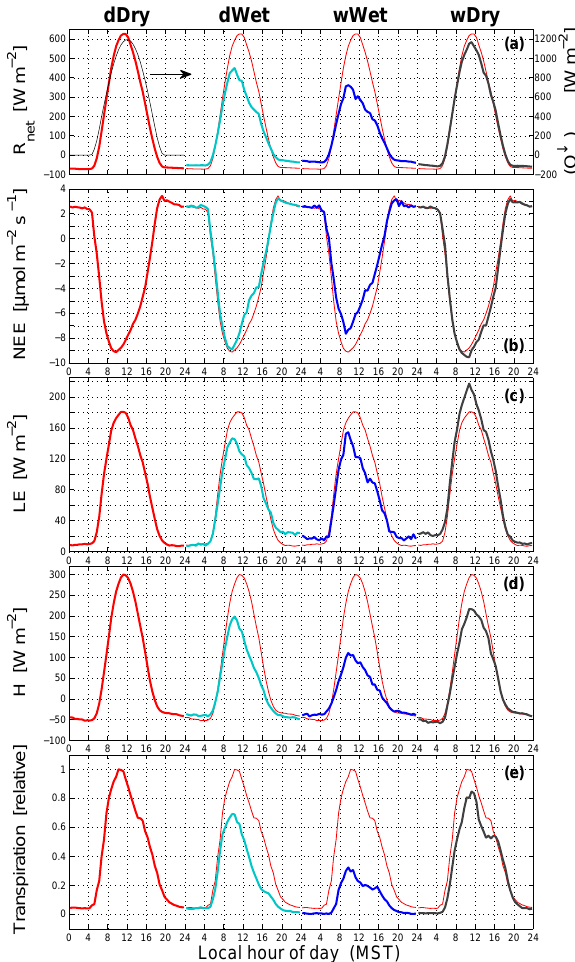
Figure 9. The mean warm-season diel cycle of (a) net radiation R net , (b) net ecosystem exchange of CO 2 NEE, (c) latent heat flux LE, (d) sensible heat flux H , and (e) transpiration (in relative units). The diel cycle for each precipitation states are shifted to the right following the description above panel (a) . For reference, the dDry diel cycle is repeated in all columns as a red line. In (a) , incom- ing shortwave radiation at the top of the atmosphere ( Q is shown as a black line in the dDry column (using the right-hand axis). Transpiration is estimated from several pine trees near the US-NR1 tower during the summers of 2004, 2006, and 2007. For all other variables, the diel cycle is calculated from 30min mea- surements between years 1999 and 2012.